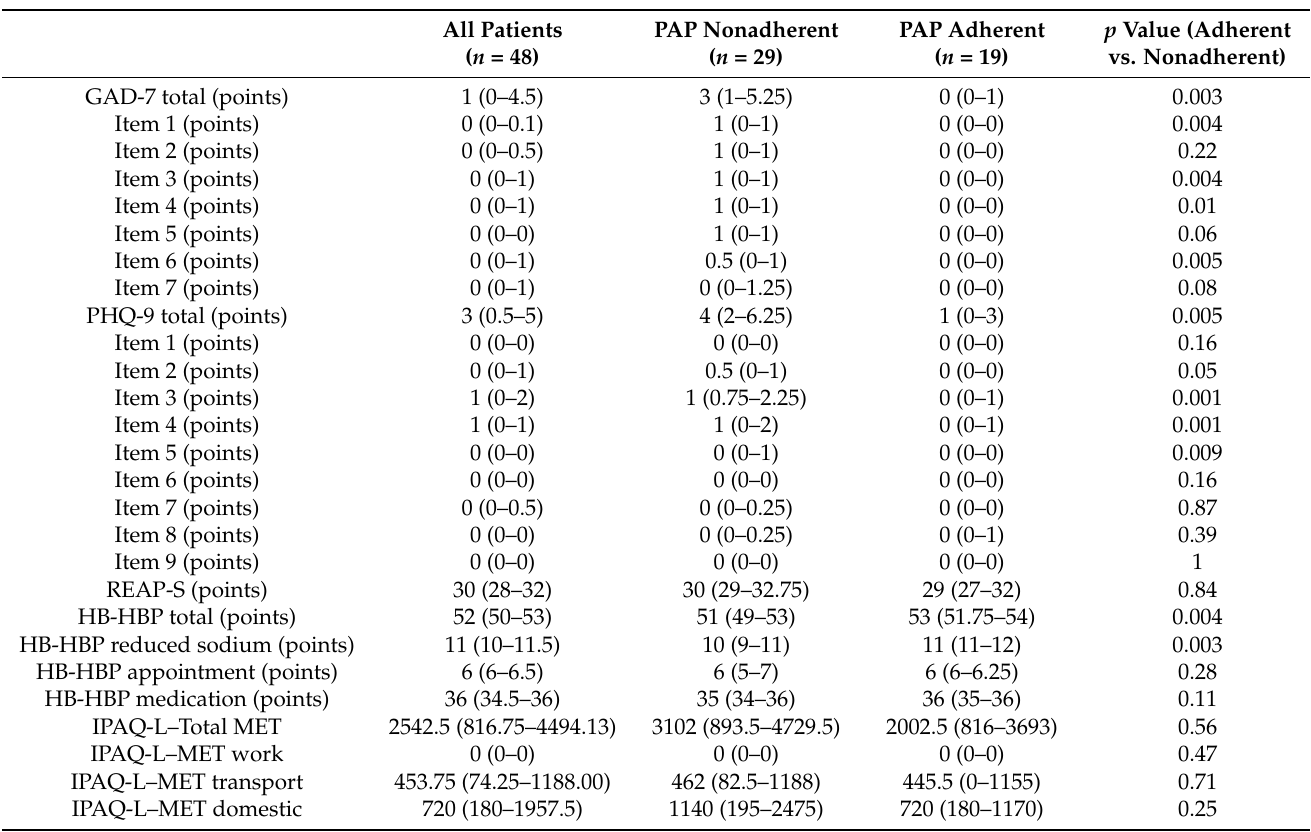
Figure 7. Changes in ESS—baseline versus follow-up. ESS: Epworth sleep score results; PAP: positive airway pressure. Table 3. Comparative analysis of anxiety, depression, diet, adherence and physical activity in PAP- adherent and -nonadherent